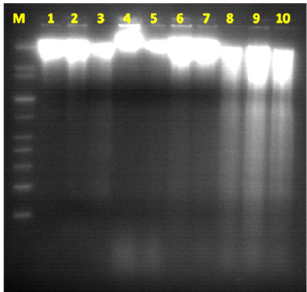
Figure 3. DNA-ladder fragmentation. The genomic DNA extracted from hepatic tissues showed a very weakly stained smear pattern upon electrophoresis, with no evidence of DNA-ladder pattern except from the reference area (1–5). In contrast, the genomic DNA extracted from samples (6–10) of polluted area revealed internucleosomal fragmentation (ladder pattern) mixed with a smear-like pattern, which are classified as signs of apoptosis and necrosis.